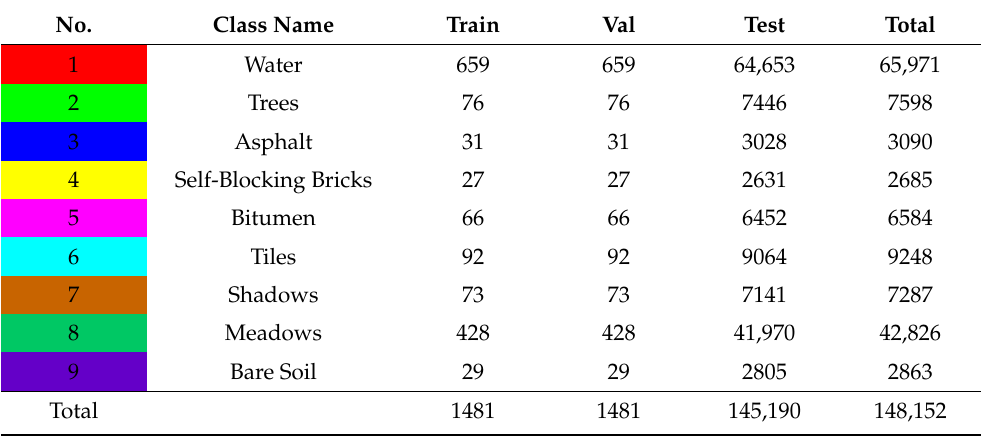
Table 2. Training validation and testing sample numbers in PC.